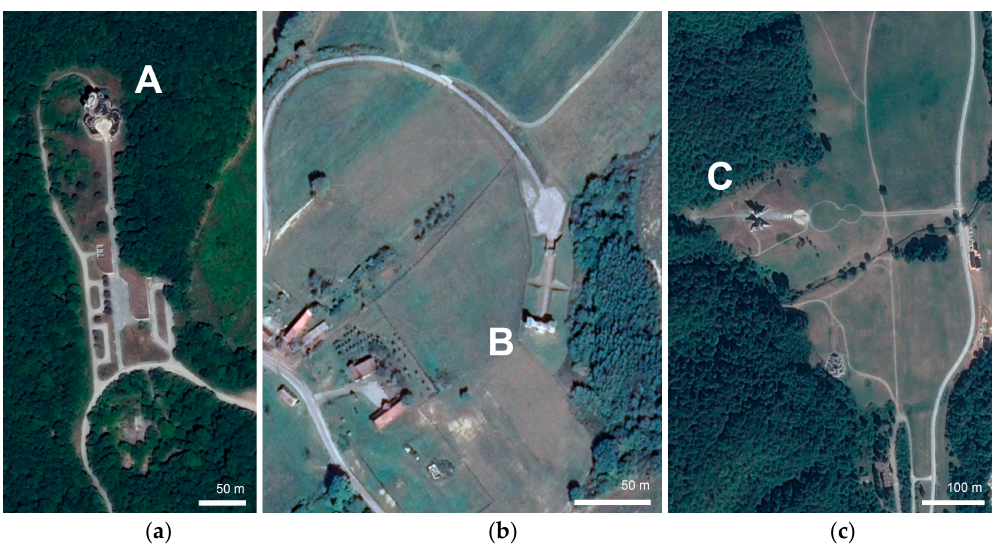
Figure 7. Remote locations of Yugoslav monuments in spectacular natural settings: ( a ) Petrova Gora Monument; ( b ) Monument to the Revolution of the People of Moslavina; ( c ) The Battle of Sutjeska Memorial Monument Complex. © 2018 CNES/Airbus Map data © 2018 Google, Source: https://www.google.com/maps/ 2018-11-11.